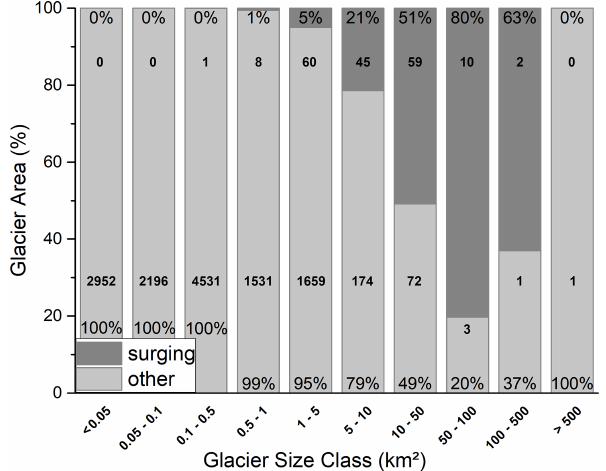
Figure 7. Size class distribution (in relative terms) of surging and other glaciers in GI-2. The upper bold numbers provide the count for surge glaciers and the lower one for all other glaciers.